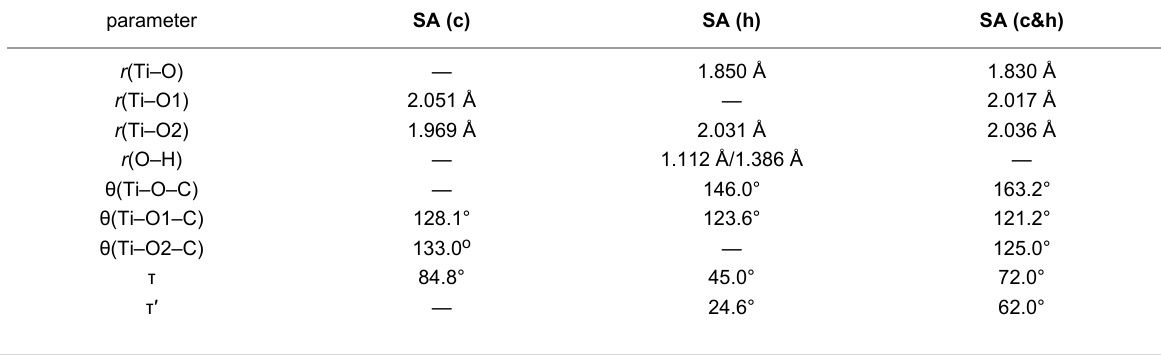
Table 3: Distances and angles relevant to the binding of SA to the catalyst, after geometry optimization at DFT/B3LYP/3-21G*